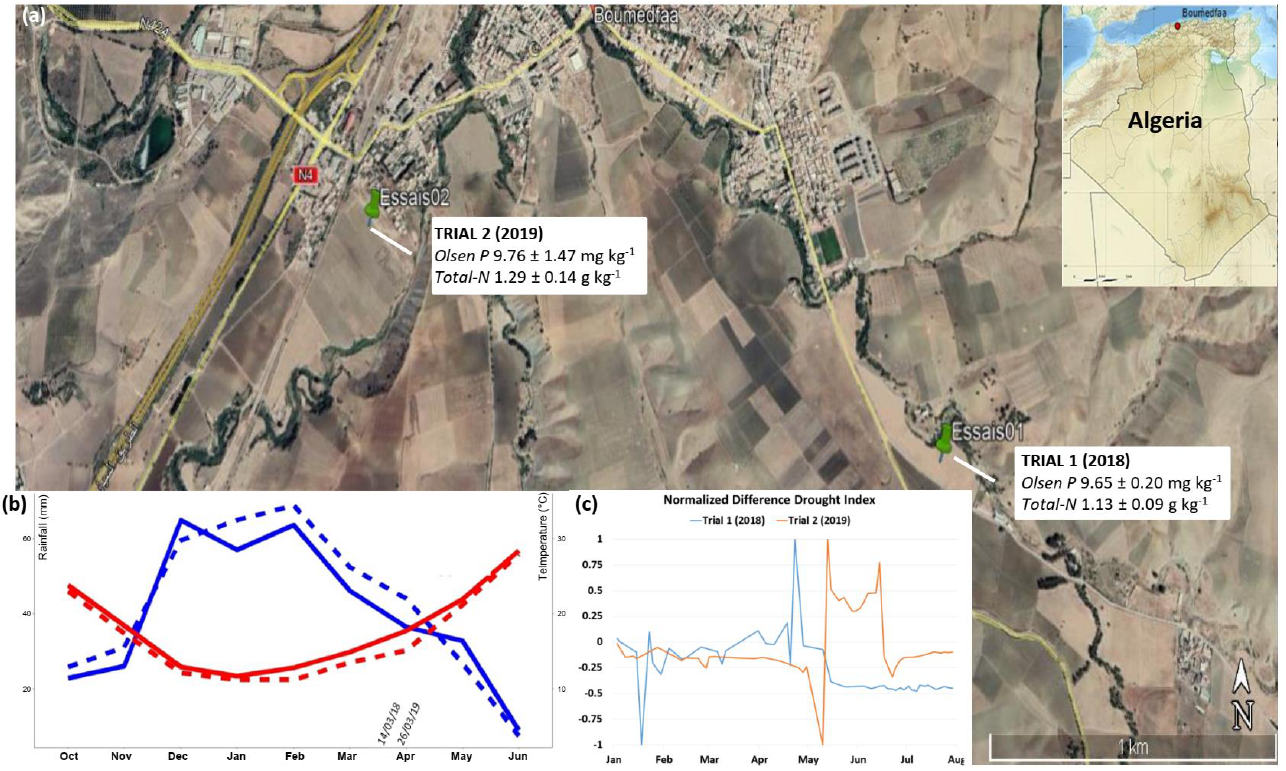
Figure 1. Geographic and pedoclimatic description of the field experimental sites. Localization of the experimental sites in Boumadfaa, Algeria, for the two cropping seasons (latitude 36°21 ′ 23.5 ″ N and longitude 2°29 ′ 16.5 ″ E for the 2018 trial, latitude 36°21 ′ 48.4 ″ N and longitude 2°27 ′ 46.9 ″ E for the 2019 trial). ( a ) The total nitrogen (N) and bioavailable phosphorus (Olsen P) contents of the soil are indicated for the two trials. More detailed information on the soil characteristics is available in Table S1. Ombrothermic diagram during the two growing seasons, 2018 (solid line) and 2019 (dotted line). ( b ) Monthly rainfall (mm) and mean air temperatures (°C) recorded under the field conditions are plotted with the precipitation scale = 2 × temperature scale. The sowing dates for the two growing seasons are indicated in italics. ( c ) Normalized difference drought index (NDDI). Positive NDDI means drought, negative means no drought.